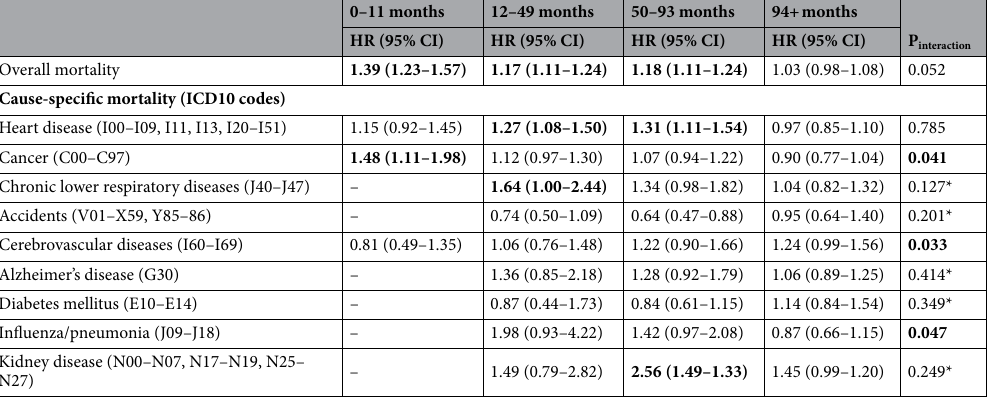
Table 3. Association of neutrophil-to-lymphocyte ratio with overall and cause-specific mortality for different time periods of follow-up. Hazard ratios describe the change in mortality corresponding to a 1-quartile increase in neutrophil-to-lymphocyte ratio. Models are adjusted for age (continuous); sex; race/ethnicity (non- Hispanic white, non-Hispanic black, Mexican American, other Hispanic, other race); smoking (never, former, current smoker), body mass index (< 18.5, 18.5–24.9, 25–29.9, ≥ 30 kg/m 2 ); baseline presence of diabetes mellitus, hypertension, and arthritis; and total white blood cell count, except for the model for diabetes mellitus-specific mortality, which did not include adjustment for diabetes mellitus. Values not shown, indicated as “–“, for categories with number of deaths less than 11. Bolded values indicate statistical significance. CI confidence interval, HR hazard ratio, Q quartile. *P interaction corresponds to a global test for proportional hazards across the four periods, except for these outcomes indicated by *, where the interaction excludes the 0–11-month